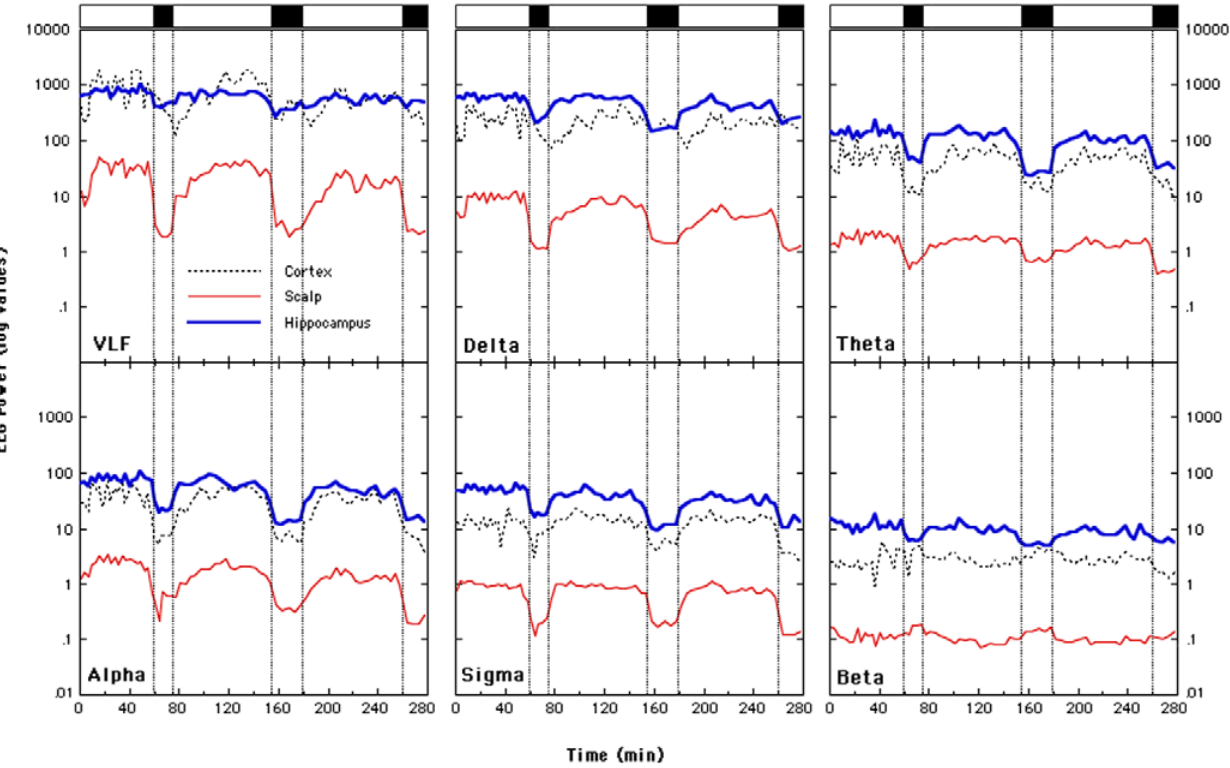
Figure 2. Time course of EEG power in the 0.5–30.0 Hz frequency range across the first three NREN-REM sleep cycles. REM periods are indicated by the black rectangles on top of the figure. Data are expressed in a logarithmic scale. Scalp recordings have been obtained by means of a bipolar (Cz-Fz) montage. Intracranial (cortex and hippocampus) stereo-EEG recordings have been obtained by a bipolar montage between two contiguous contacts of a platinum-iridium microwire. Very low frequency range (VLF, 0.5–1.0 Hz); delta frequency range (1.1–5.0 Hz); theta frequency range (5.1– 8.0 Hz); alpha frequency range (8.1–12.0 Hz); sigma frequency range (12.1–15.0 Hz); beta frequency range (15.1–30.0 Hz).